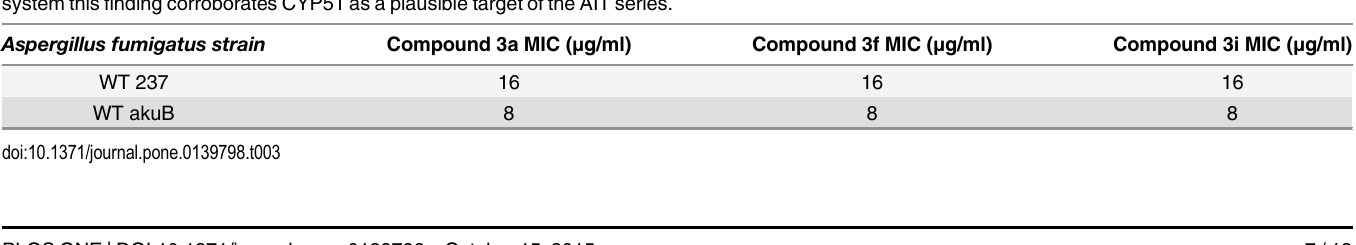
Fig 2. Computational binding mode analysis of AITs and M . tubercolosis CYP51. A) X-ray structure of CYP51 (green cartoon representation with heme cofactor as sticks with bound iron as brown sphere) in complex with a small molecule inhibitor (PDB: 2CIB). B) Similar interactions and an analogous three- dimensional arrangement are shown for compound 3f of the AITs (cyan sticks). C) Overlay of the parent 1,3,4-thiadiazole of Oruc et al [Oruc04] with compound 3a of the AITs. Positioning of ring centers, exit vectors, and overall shape are very similar, thereby plausibly explaining a similar bioactivity profile.